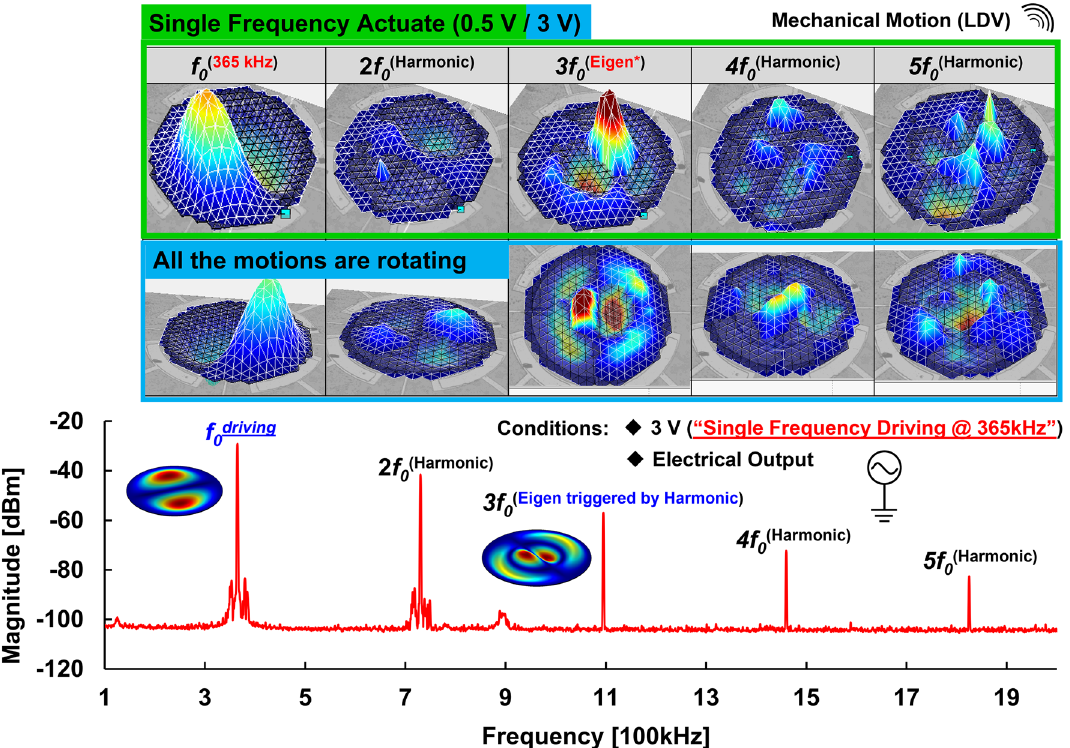
Figure 6. Mechanical motions with and without rotations by a single-tone driving signal of 0.5 V and 3 V, respectively: The mechanical motions were captured by LDV and driven in the rotation frequency band (at 365 kHz). The generation of higher-order harmonics and the parametric effect were also validated by the SA through the integrated inner electrode of the